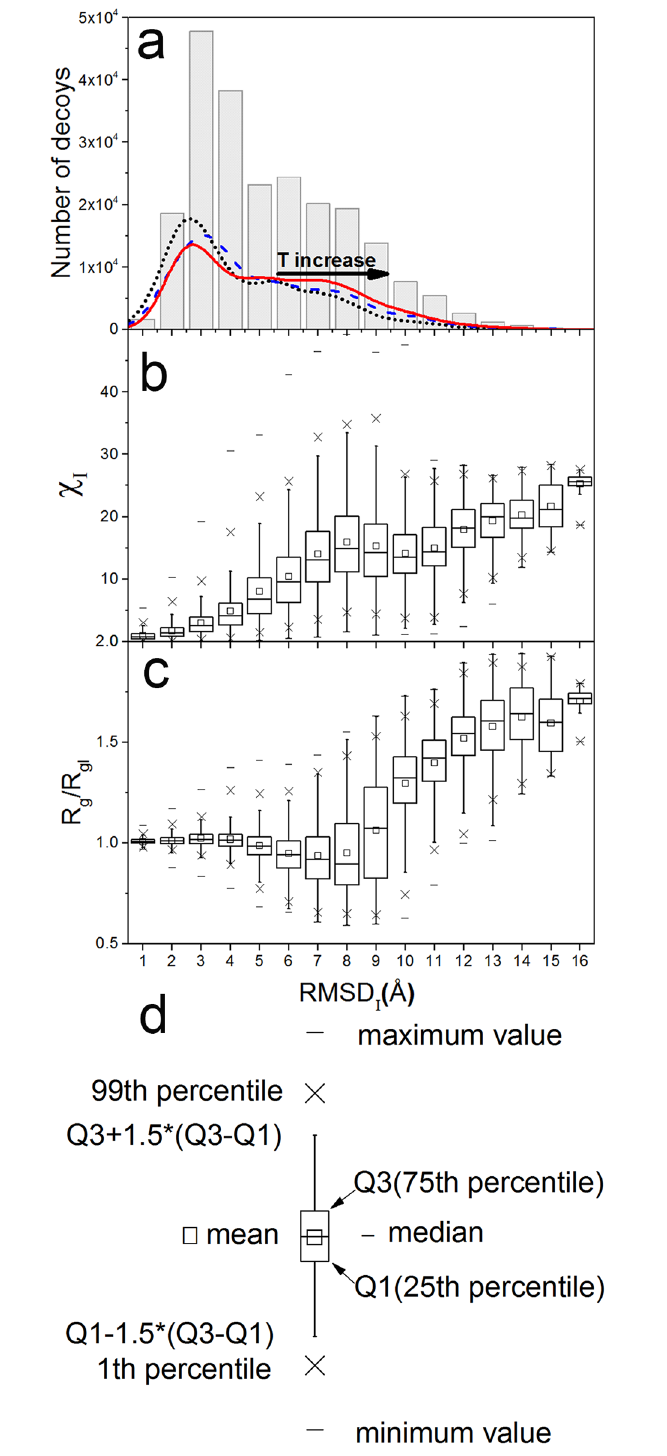
Fig 4. The distribution of decoys, χ I and R g /R gI against RMSD I . (a) All 22,5000 decoys generated in the forward MD simulations (bars), and decoys in simulations at 310K (dotted lines), 340K (dashed lines) and 370K (solid line); (b) the discrepancy in the scattering intensity profiles ( χ I ); and (c) the size ratio (R g /R gI ). Panel (d) explains the symbols used in panels (b) and (c). RMSD I represents the RMSD of decoys from their initial